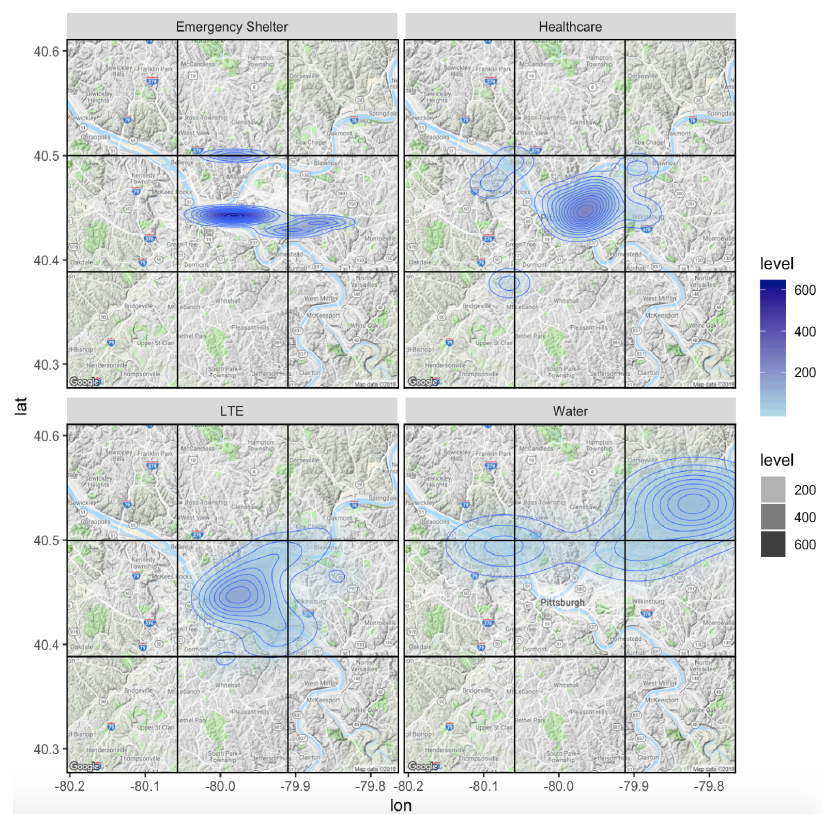
Figure 4. Critical node heat map for each individual infrastructure.